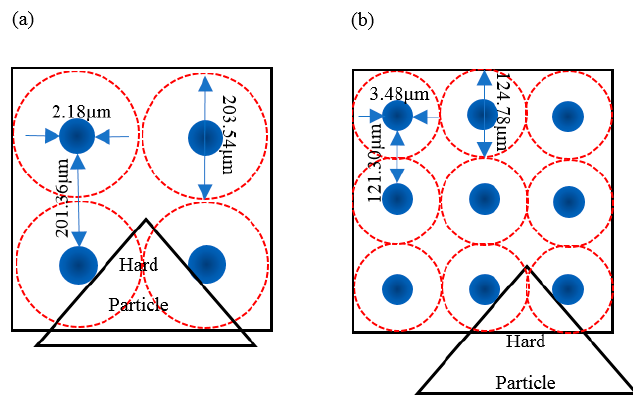
Figure 11. Schematic diagram of carbides in steel and hard particles during wear process: ( a ) sample A, ( b ) sample B. The solid circle represents the actual particle (i.e., carbide of the carbide nucleated oxide) and the dotted circle is the auxiliary line to acquire Z in Figure 11. As can be seen from Figure 11, the distance Z between the actual adjacent particles is 201.36 μ m for sample A, and Z for sample B is 121.30 μ m. The triangle represents hard particle (i.e., silicon carbide particle). The length of hard